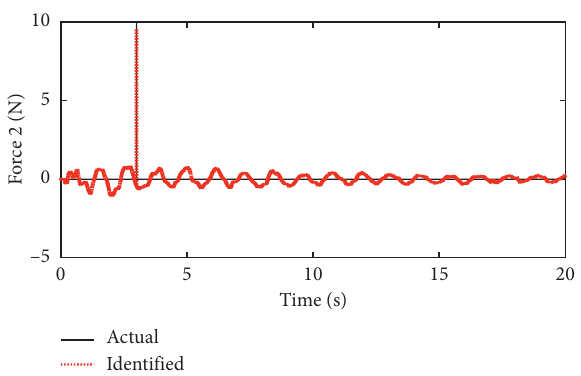
Figure 9: Identification of external load u